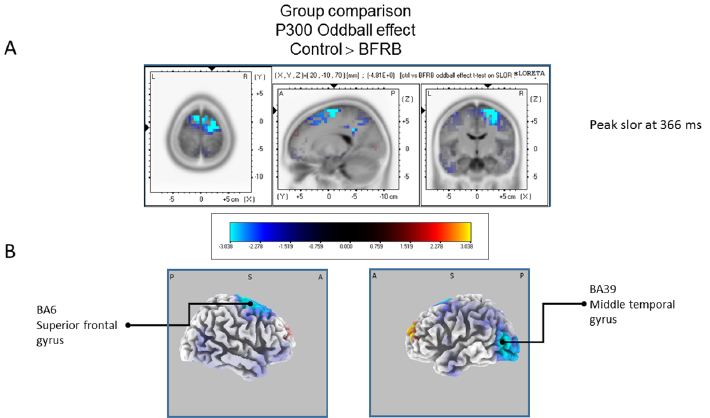
Figure 5. Comparison of the oddball effect between Control participants and BFRB patients based on the standardized low-resolution brain electrotomography (sLORETA) current source density localization of the group effect (contrast: “Ctrl” > BFRB”) in the peak activation of the P300 component within a 300–550 ms time windowImages have been obtained after statistical non-parametric mapping (SnPM) and co-registration to the stereotaxic Talairach space based on the Co-Planar Stereotaxic Atlas of the Human Brain [83] and the probabilistic MNI-152 template [81]. Activated voxels are indicated by blue colors [after correction for multiple comparisons ( p < 0.05). ( A ) The peak of highest cortical activity group difference has been found in parts of the superior frontal gyrus (BA6) and the middle temporal gyrus (BA39). ( B ) A shifted transverse view of the left and the right hemisphere, showing cortical activations on the three-dimensionally rendered Colin27 template [89]. A, anterior; P, posterior; MNI, Montreal Neurological Institute; X, Y, Z, corresponding MNI coordinates; BA, Brodmann area. Brain Sci. 2017 , 7 , 76